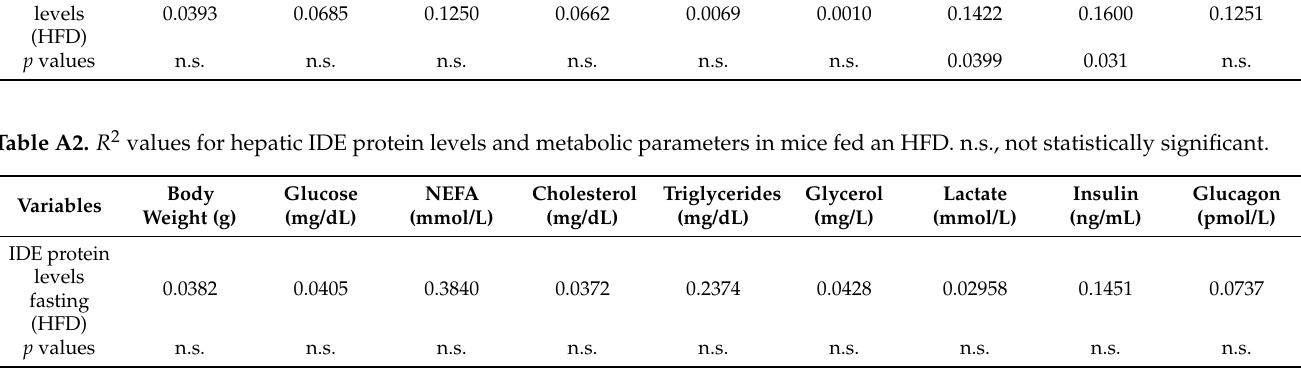
Figure A5. Hepatic IDE protein levels in obese mice. Tissue extracts from the liver of male +/+ and db / db mice were prepared and analyzed for IDE protein levels. Upper panel: densitometric analyses of IDE. The y axis represents the ratio of IDE versus actin in arbitrary units. Lower panel: representative Western blots depicting IDE. Data are the means ± SEM. N = 9–10 mice per condition. * p < 0.05 vs. +/+ by Student’s t -test. Table A1. R 2 values for hepatic Ide mRNA levels and metabolic parameters in mice fed an HFD. n.s., not statistically significant.